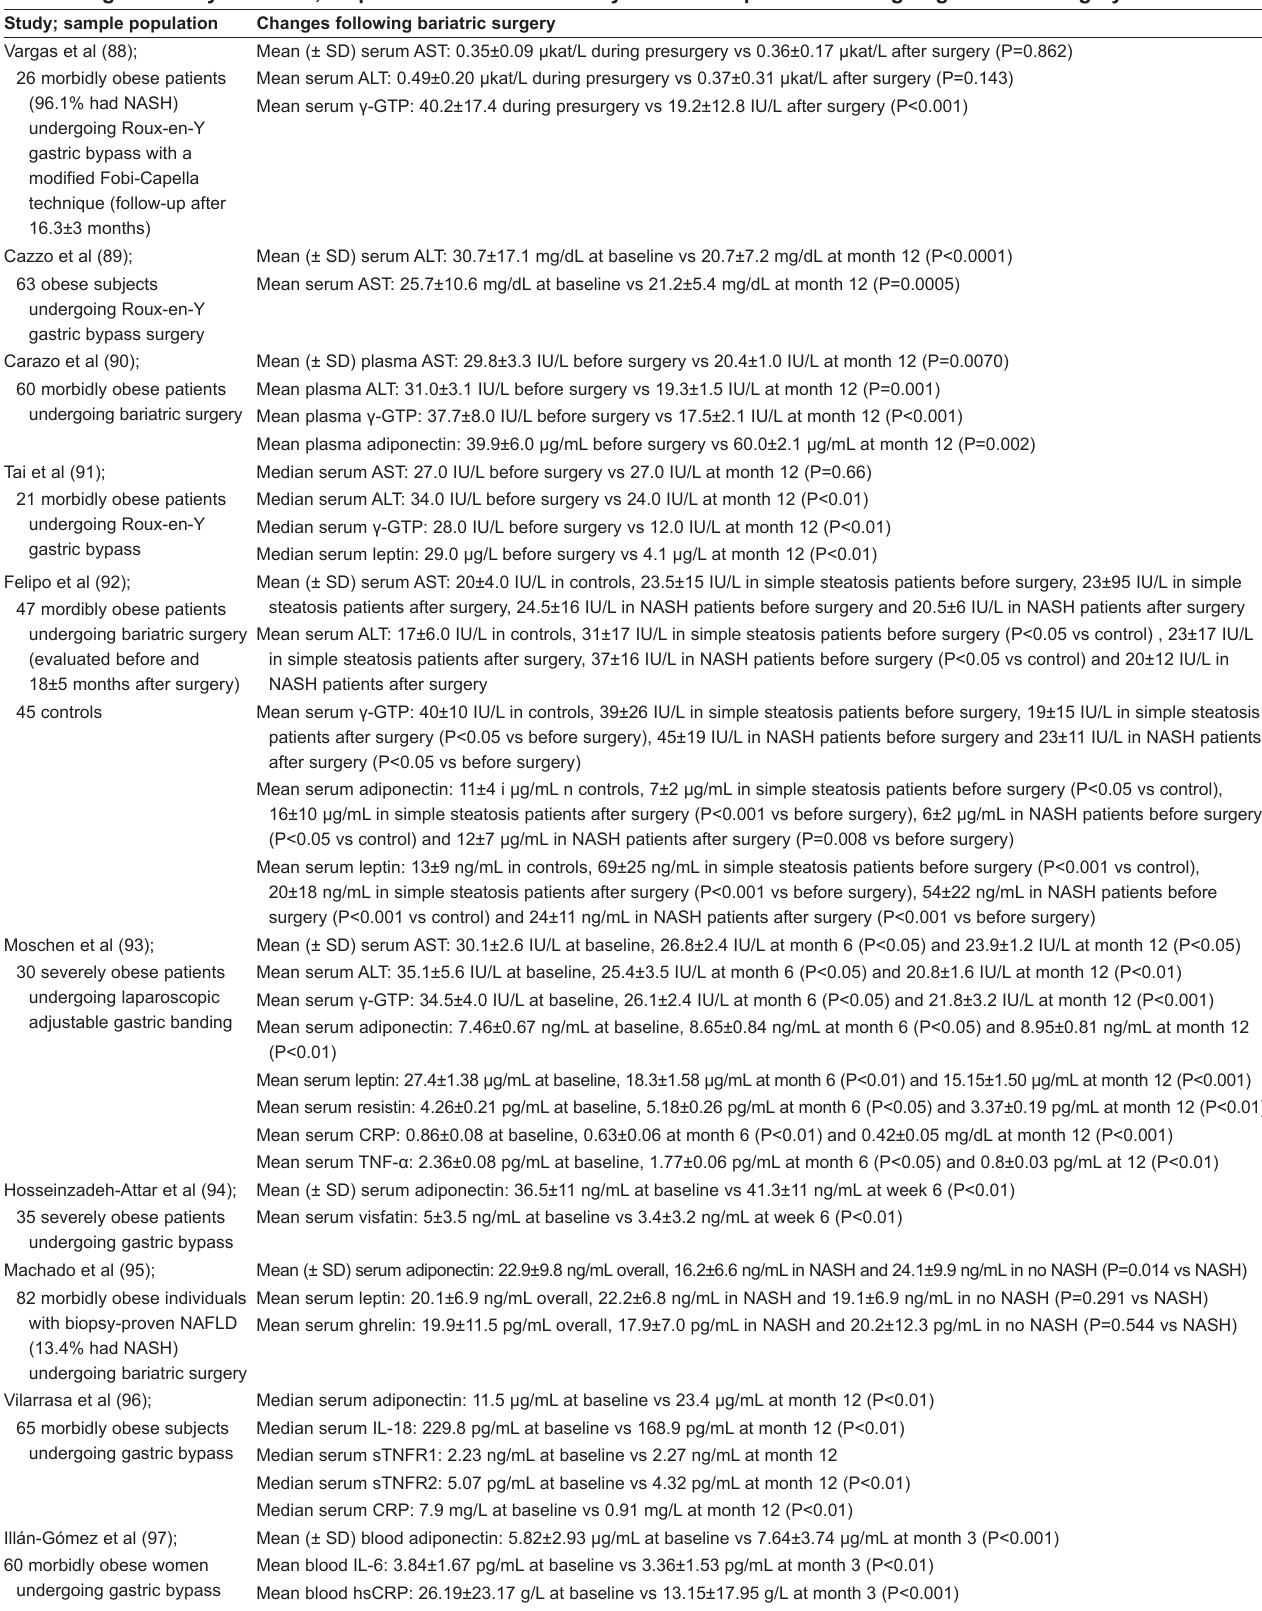
TABlE 5 Circulating liver enzyme levels, adipokines and inflammatory markers in patients undergoing bariatric surgery Study; sample